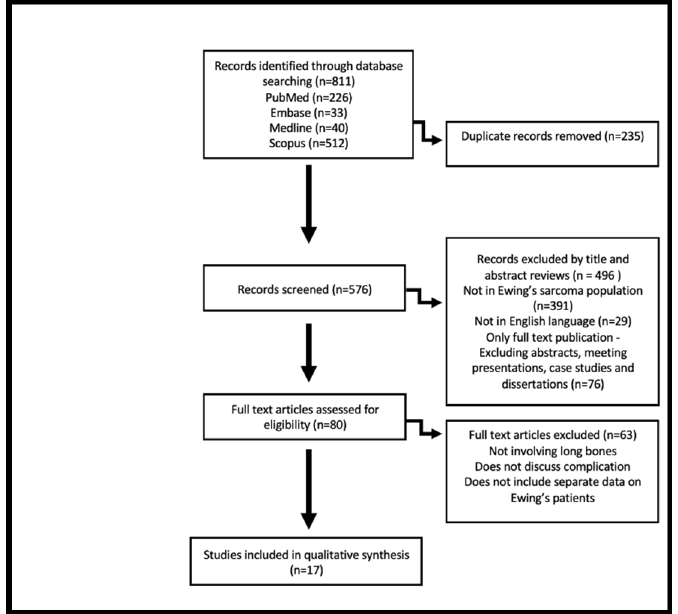
Figure 1. Flow diagram visually summarising results of literature search and screening process based on Preferred Reporting Items for Systematic Reviews and Meta-analysis (PRISMA) guidelines [12].